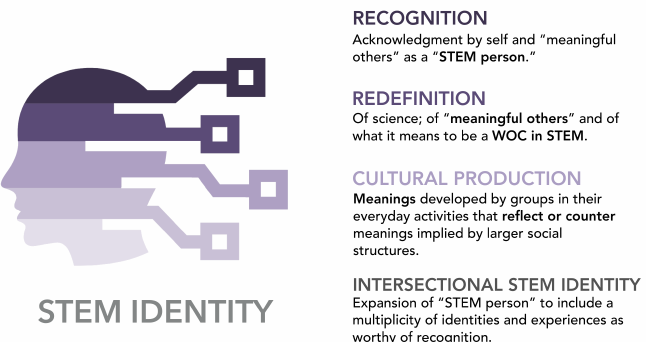
Figure 1. The earliest conceptions of the #VanguardSTEM intersectional science, technology, engi- neering and mathematics (STEM) identity framework and the literature and concepts from which it emerged (for example, Carlone and Johnson 2007; Ong et al. 2018; Wenger 1998). Our earliest models leaned heavily on recognition as a way to build STEM identity, using cultural production to redefine the meaning and contributions of women of color in